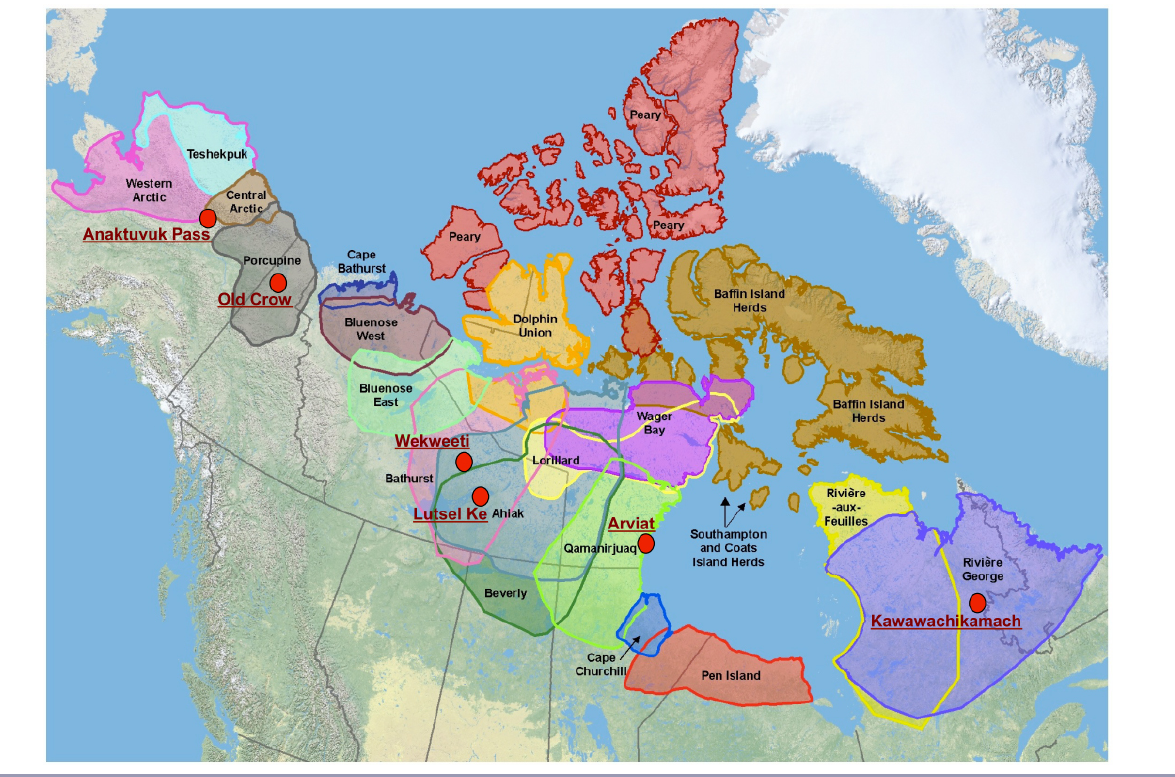
Fig. 2 . Map showing the six participating communities of the Voices of the Caribou People project along with the ranges of North American caribou herds (Adapted from Gunn et al.